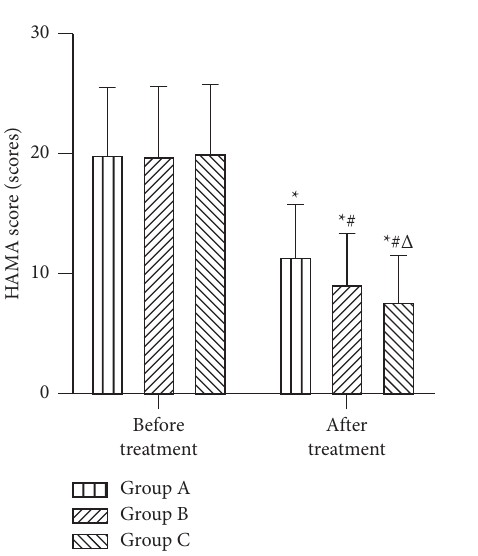
Figure 3: Comparison of 3 groups of HAMA scores ( x ± s , scores). Compared with the same group before treatment, ∗ P < 0 . 05; compared with group A after treatment, # P < 0 . 05; compared with group B after treatment, Δ P < 0 . 05.